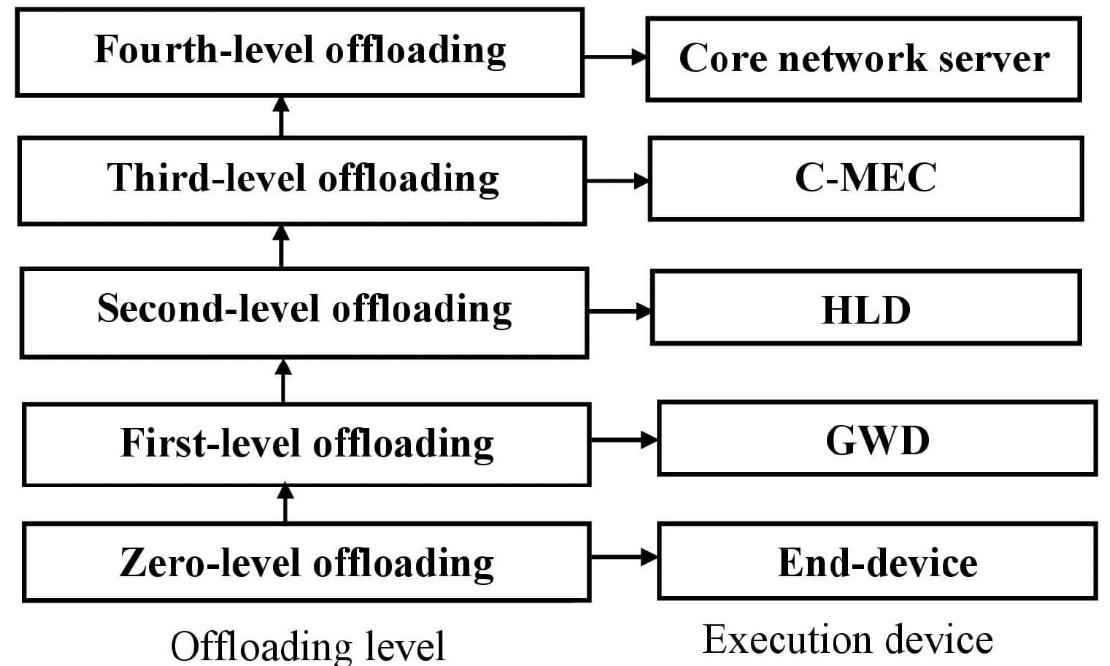
Figure 5. Main offloading levels of device-to-device communications (D2D) networks. However, if there are no available resources for local execution, the task is offloaded to the higher offloading level. There are four available offloading levels. Each of them corresponds to an executing device. The first level represents the offloading to the GW device, while the second offloading level represents the offloading to the HL device. The third offloading level is the edge server, i.e., C-MEC server, while the last level is the core networks cloud. Figure 6 illustrates heterogenous task handling and offloading over a D2D network, using the proposed offloading scheme